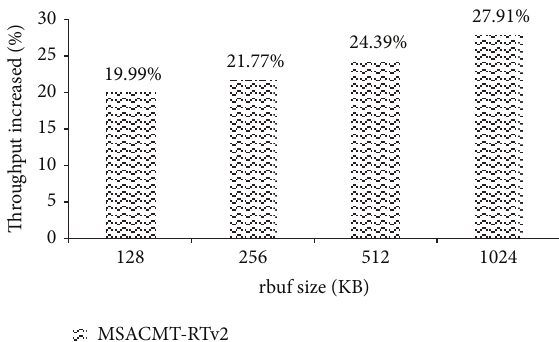
Figure 4: Percentage of throughput for various file